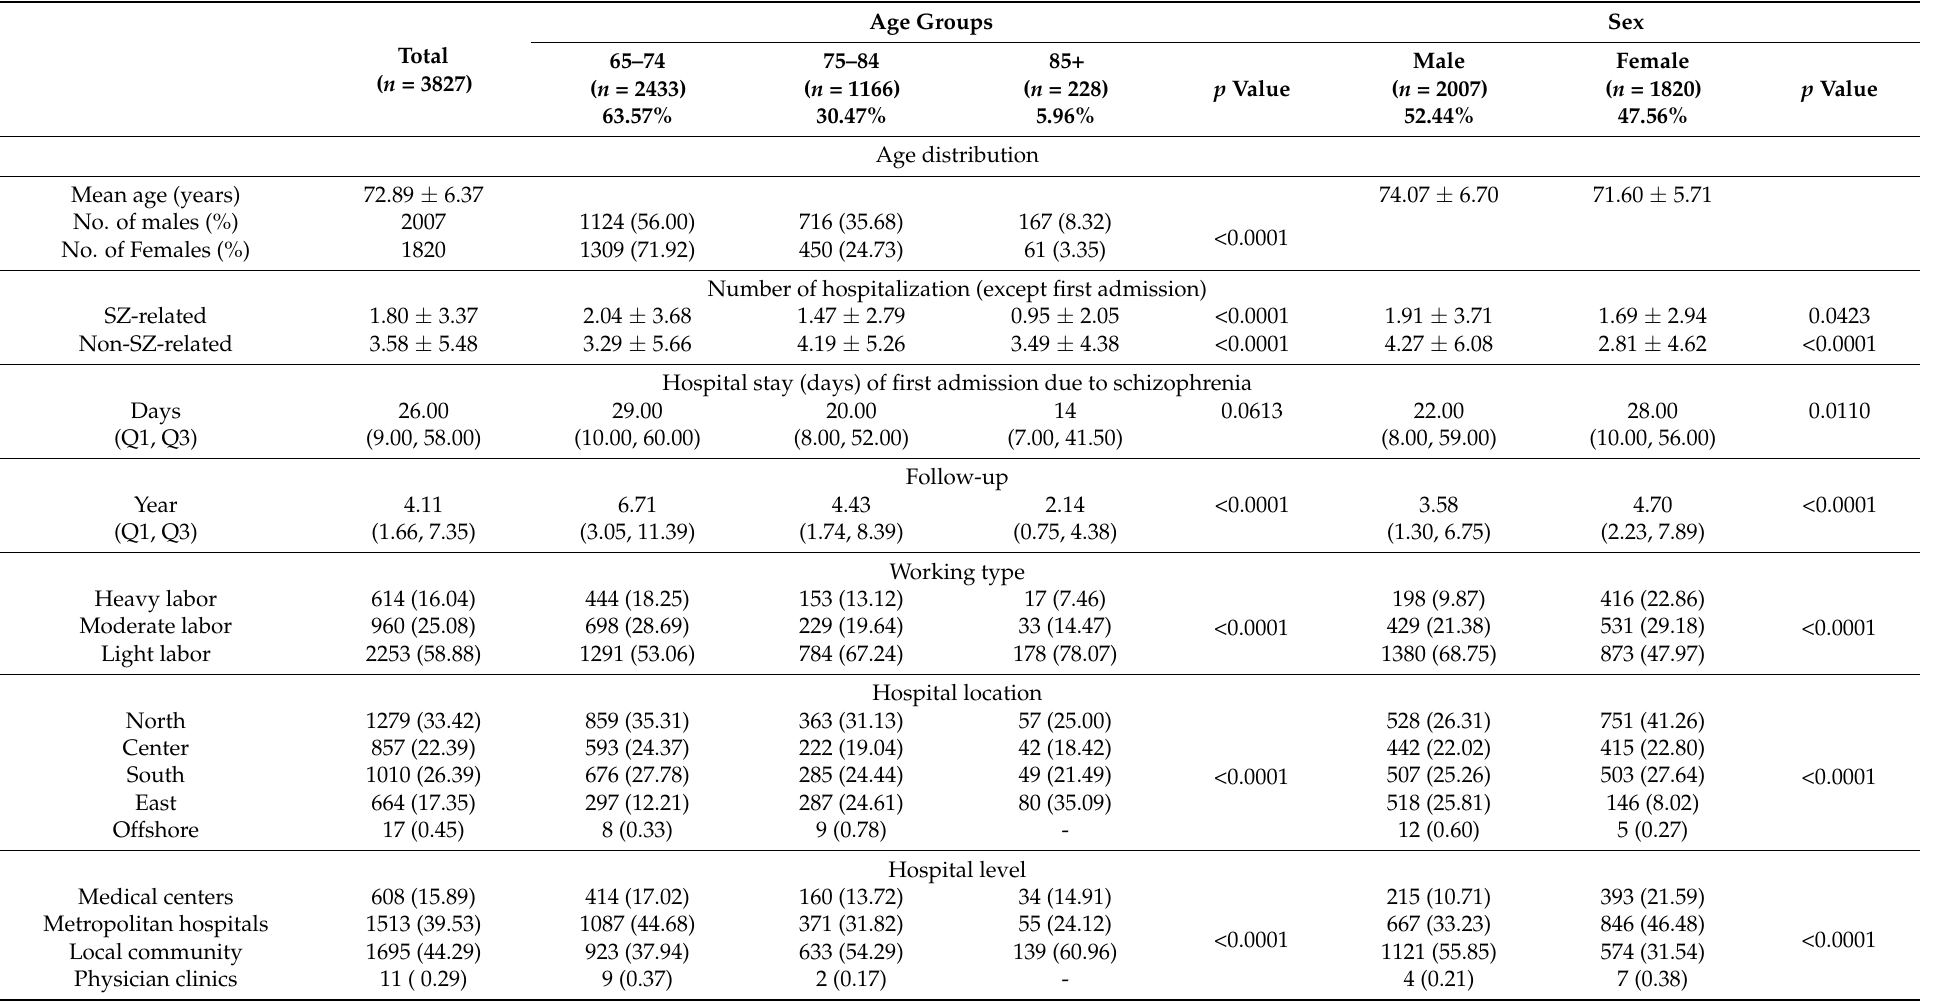
Table 1. Baseline demographics and clinical characteristics of the patient population (age-group and sex